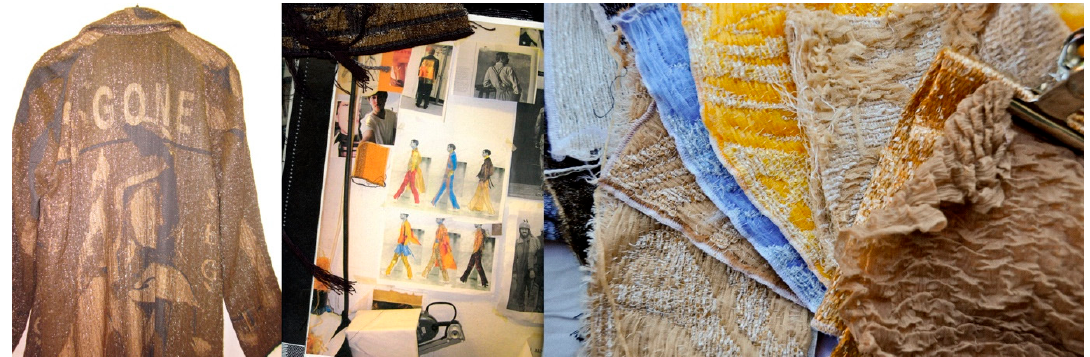
Figure 3. Maria Korkeila 2016, Portfolio with visual research, woven jacquard experiments, and the final collection. Photo credit: Maria Korkeila (used by permission).